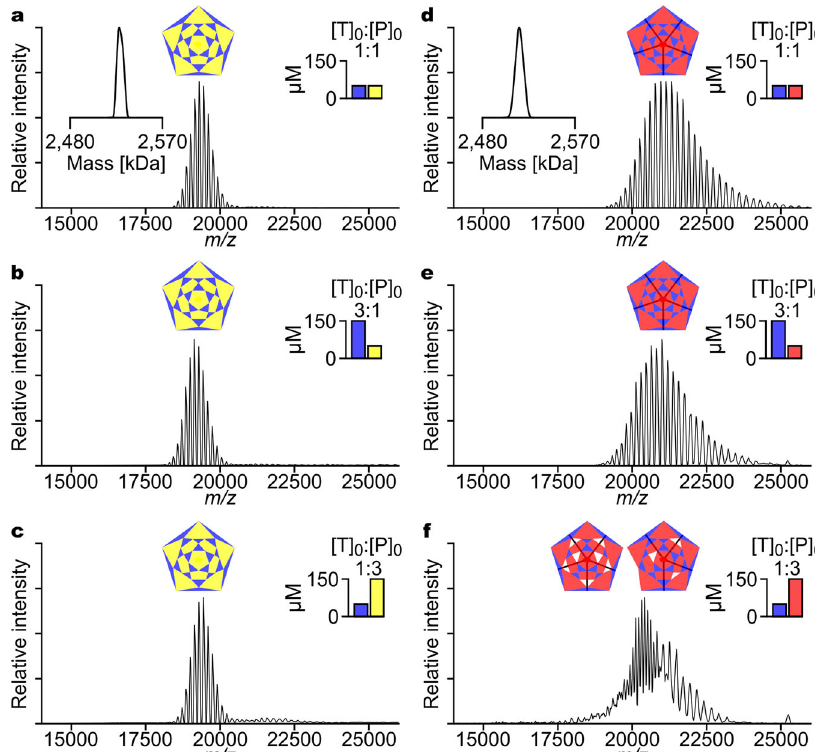
Fig. 2 Determination of the precise composition of I53-40 and I53-50 assemblies by native mass spectrometry. Native mass spectra of SEC-puri fi ed I53-40 assemblies ( a – c ) and I53-50 assemblies ( d – f ). The subunit stoichiometry of the in vitro assembly reaction that produced each material is indicated by the bar plot insets. Insets in a and d show the deconvoluted masses of the materials puri fi ed from reactions where [T] 0 = [P] 0 . Assemblies deriving from unpuri fi ed assembly reactions were analyzed in a – d , whereas e – f show assembly reaction products after SEC puri fi cation. The mass spectrum for the I53-50 [T] 0 :[P] 0 = 1:3 assembly reaction ( f ) reveals peak series from at least two different species, neither of which overlaps with the complete architecture. Diagrams show representations of complete and hypothetical partial nanomaterials lacking trimeric building blocks. Source data are provided as a Source Data fi